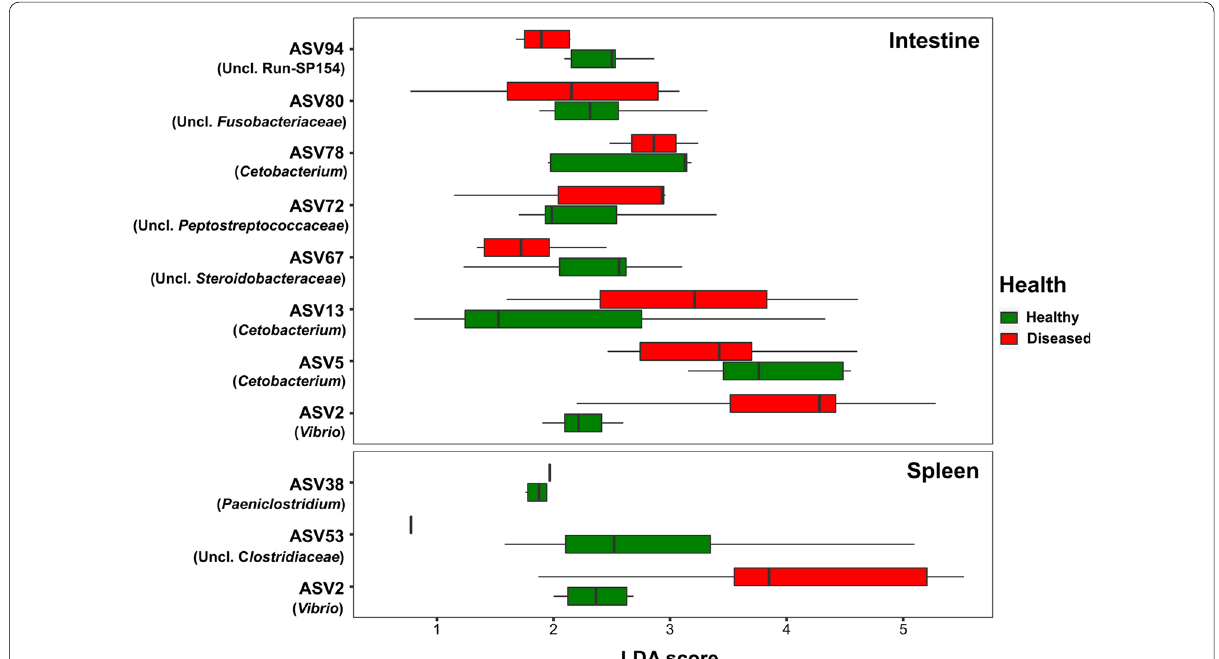
Fig. 4 LDA scores of the ASVs from intestines (top) and spleens (bottom) of healthy and diseased fish. The ASVs presented are those with the highest LDA score by LEfSe analysis. Uncl.,